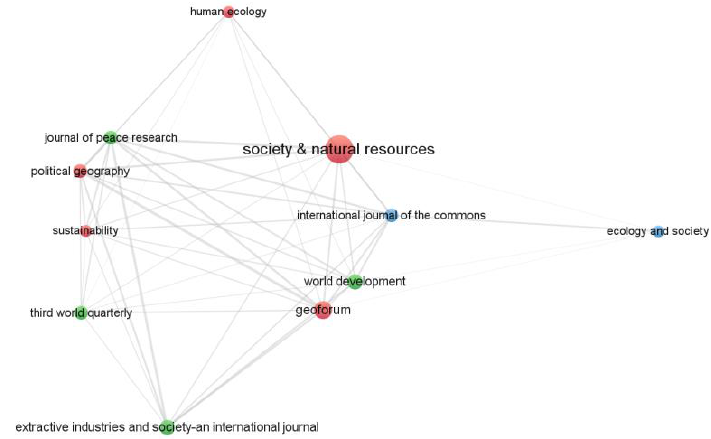
Figure A2. Network of prominent journals on Dutch disease.